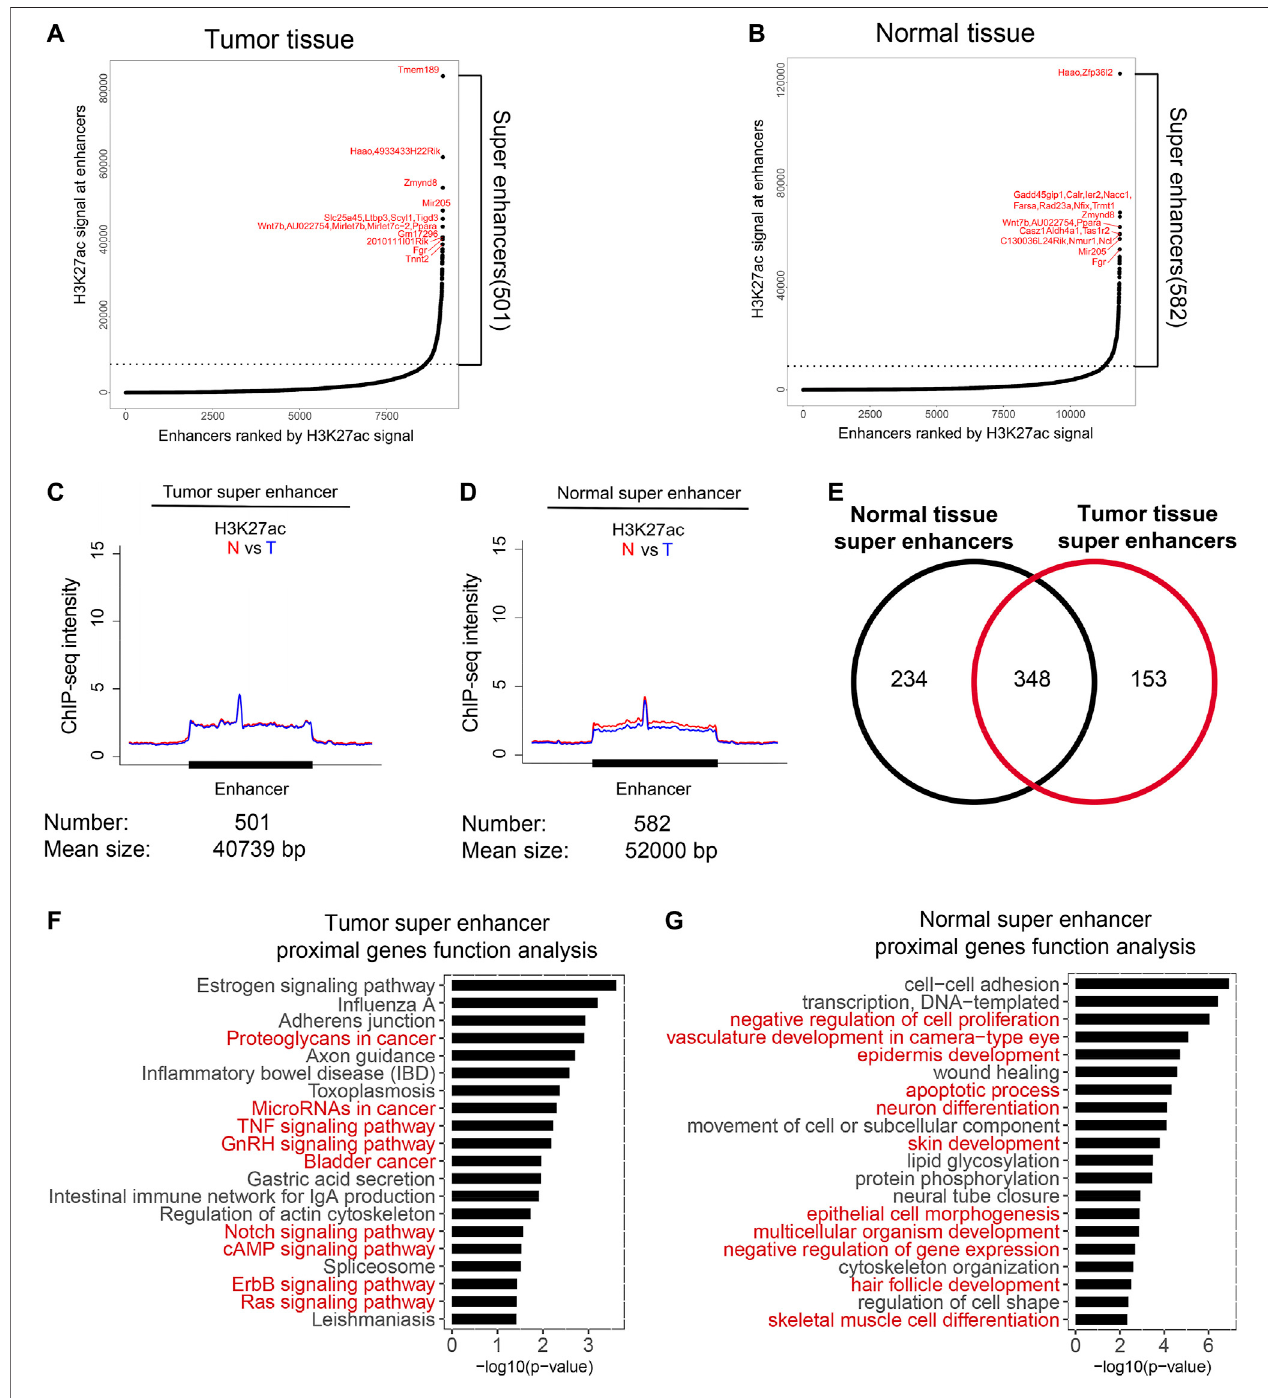
FIGURE 3 | Identi fi cation of variant super enhancer loci in HNSCC. (A and B) Super enhancers in normal and tumor tissues were identi fi ed as described in the method section. The proximal genes of top 10 super-enhancers in normal and tumor tissues were marked. (C and D) Metagene analysis of mean H3K27ac ChIP-seq densityacross501super-enhancersintumor (C) and582super-enhancersinnormaltissues (D) .Metageneplotwascenteredontheenhancerregion.Thenumberand mean size of super-enhancers were shown. (E) Venn diagrams showed the overlapped super-enhancers number between normal and tumor tissues. (F) Gene function analysisofthe proximal genes fortumor super-enhancers. Signaling pathways associatedwithcancer werehighlighted inred. (G) Genefunctionanalysisofthe proximal genes for normal super-enhancers. Red markers represented signaling pathways associated with development processes were highlighted in red.